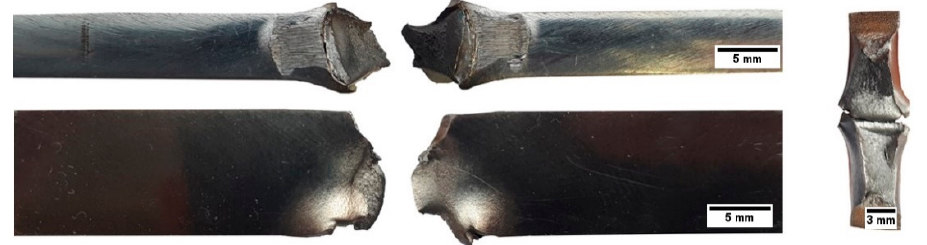
Figure 8. Fractured sample after separation by joining the hinges (three views of the same sample).